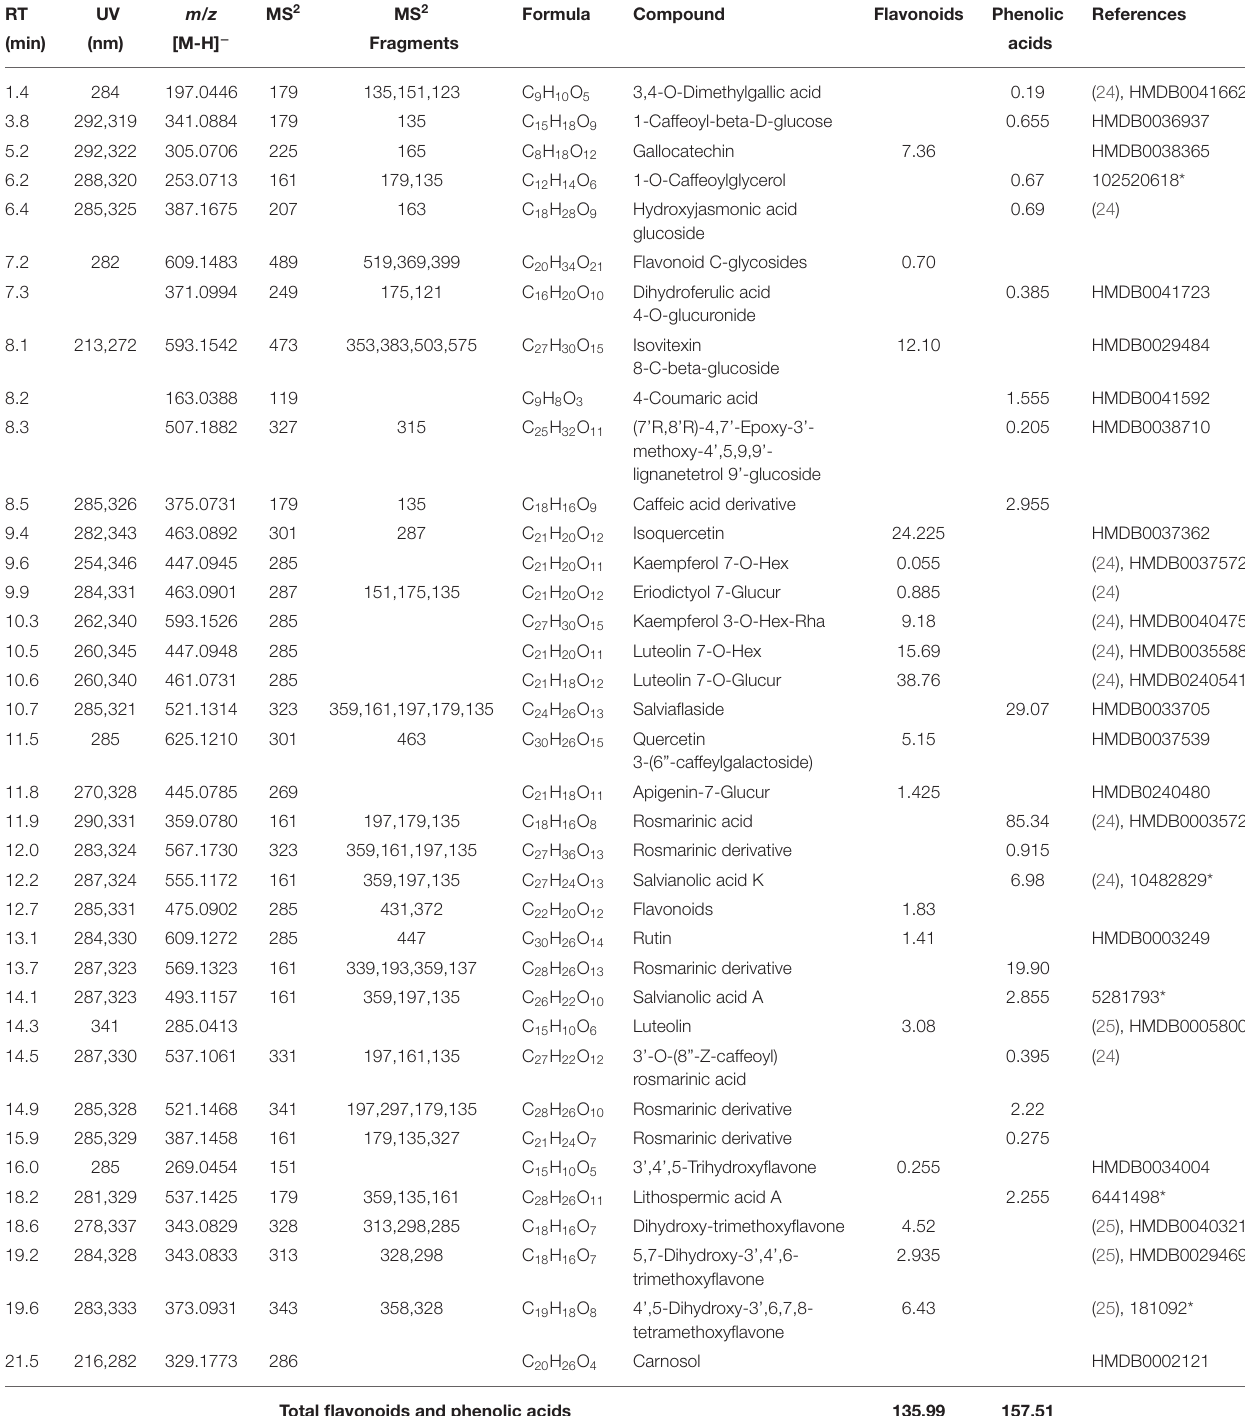
TABLE 2 | Contents of the flavonoids and phenolic acids (mg/g of extract) identified in the T. vulgaris extract.